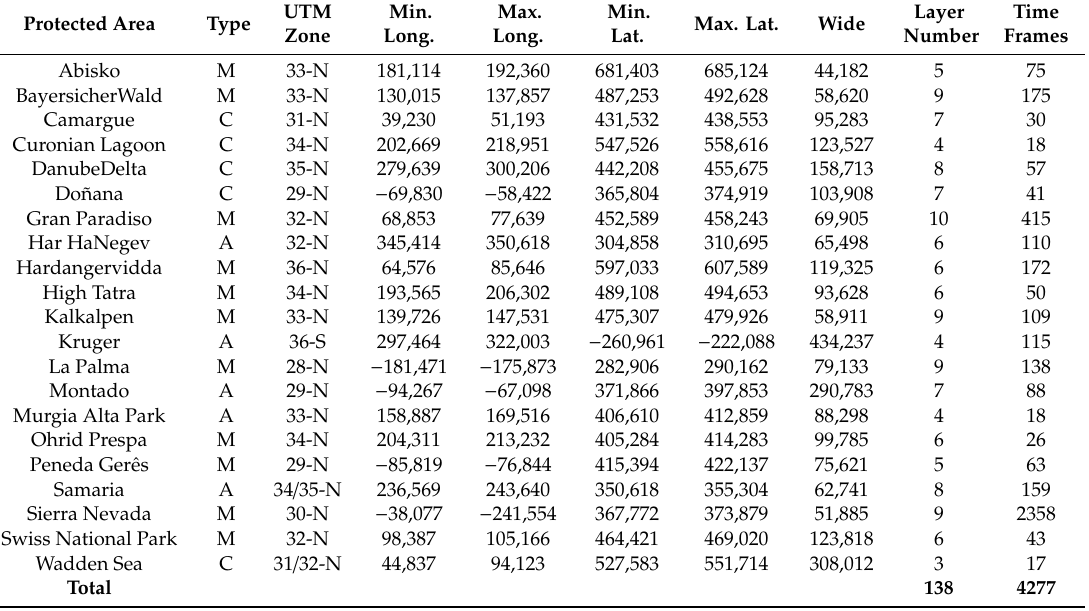
Table 1. Protected areas in the ECOPotential project. Longitude-latitude bounding box includes a 15 km bu ff er. Imagery time series are not added to layer number. Ecosystem type: M for mountain, A for arid and semi-arid and C for coastal and